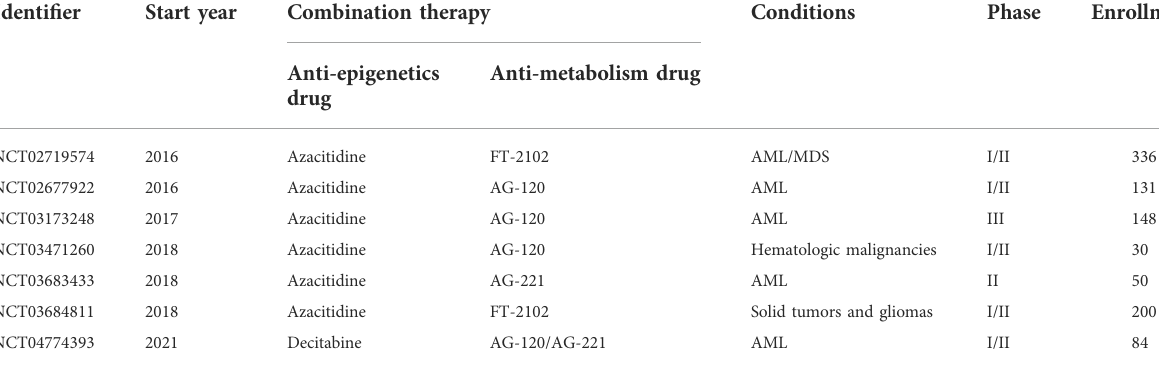
TABLE 6 Ongoing clinical trials of combined anti-epigenetic drugs and anti-metabolism